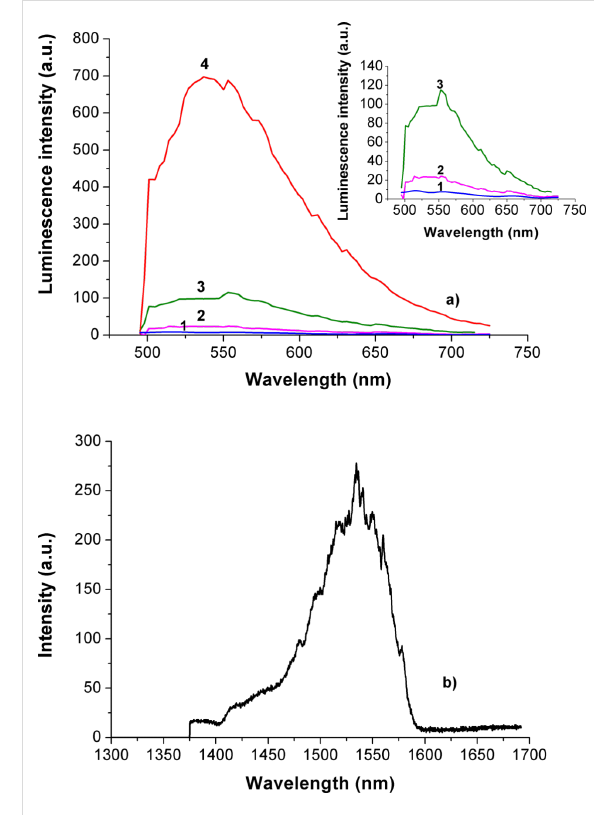
Figure 7: Luminescence spectra of the polymer nanocomposites films. a) Excitation at 488 nm: 1 - UDMA/IDA + 10 wt % SiO 2 NPs (14a); 2 - UDMA/IDA + 10 wt % SiO 2 NPs + 0.15 wt % AuNPs (14Au); 3 - UDMA/IDA + 10 wt % SiO 2 NPs + 0.17 wt % Er/Yb oxide NPs (50a) 4 - UDMA/IDA + 10 wt % SiO 2 NPs + 0.17 wt % Er/Yb oxide NPs + 0.15 wt % AuNPs (50Au) b) Excitation at 980 nm: UDMA/IDA